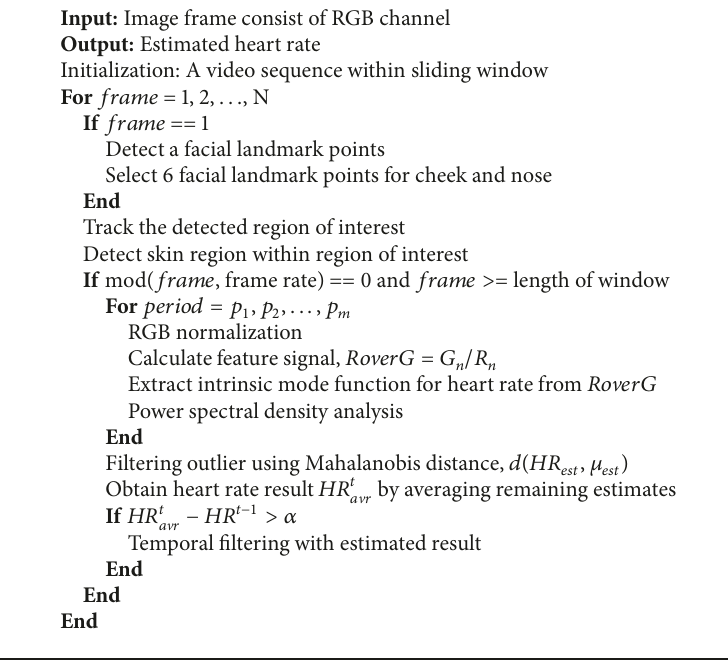
Algorithm 1: Heart rate estimation algorithm.